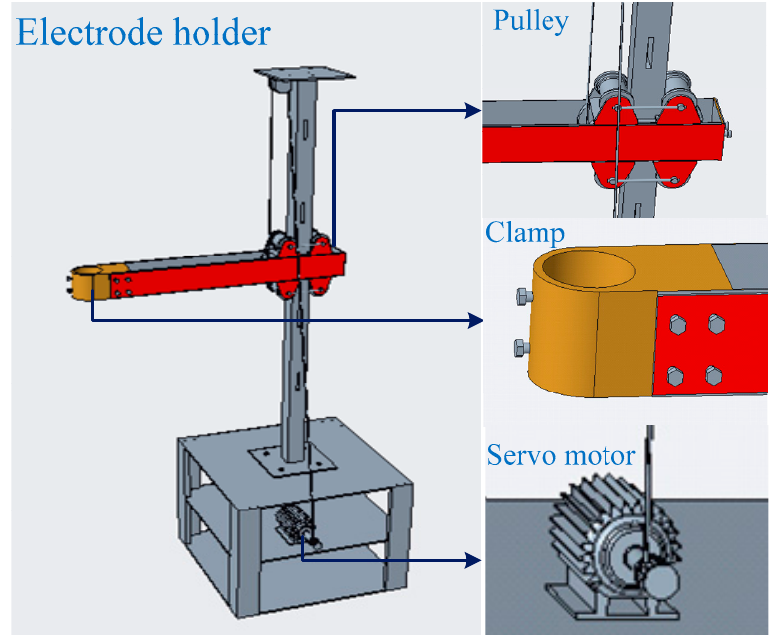
Figure 2. 3D schematic diagram of the electrode holder.